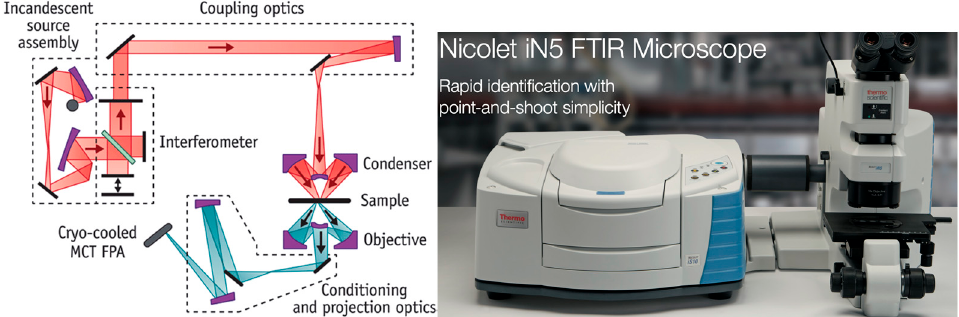
Figure 4. Left —Schematic of an FTIR microscope. Reprinted with permission from the March/April 2014 edition of BioOptics World Copyright 2014 by PennWell. Right —Photograph of a modern FTIR benchtop microscope. Photograph provided by Thermo Fisher Scientific.